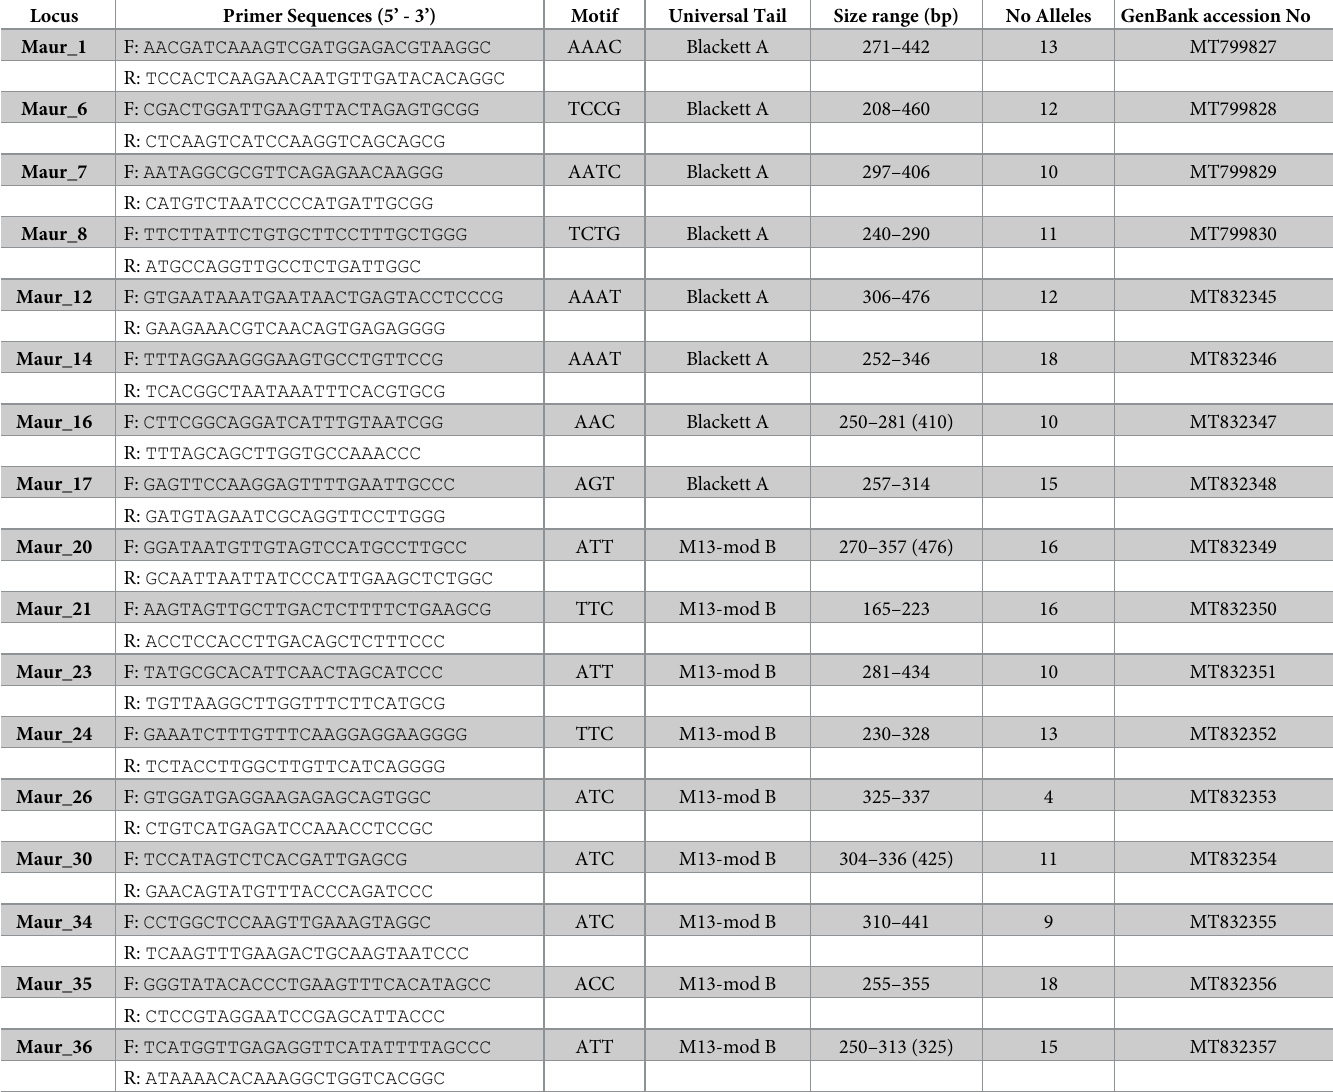
Table 2. Characteristics of novel microsatellite loci developed for M . auretenra : Locus name, forward and reverse primer sequences, motif, universal tail (fluores- cence label), base pairs size range, number of alleles and GenBank accession number. Locus Primer Sequences (5’ -